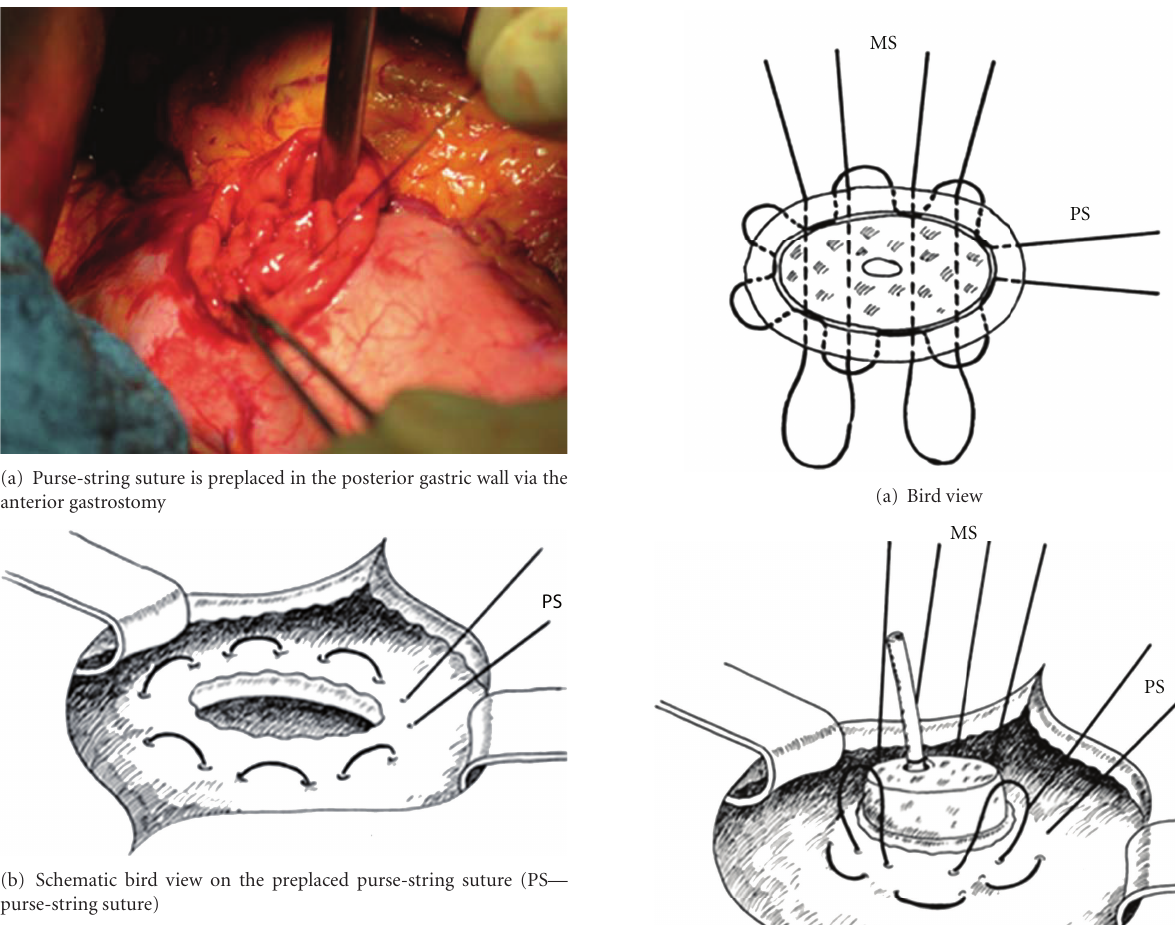
Figure 3: Preplaced purse-string suture (PDS II 2.0 MH plus, 70cm) at the posterior gastric wall.